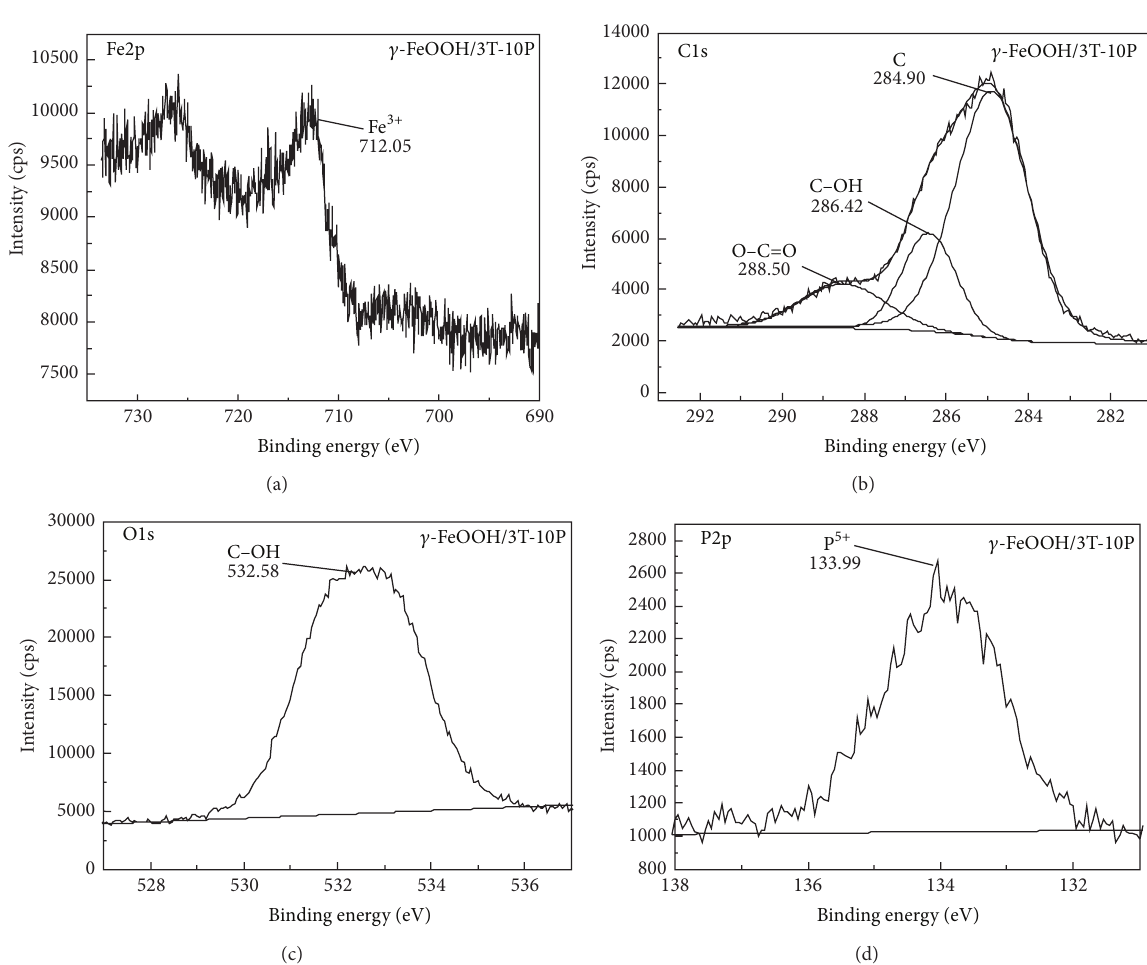
Figure 8: XPS spectra of the products formed from the reaction of 𝛾 -FeOOH and 3T-10P.